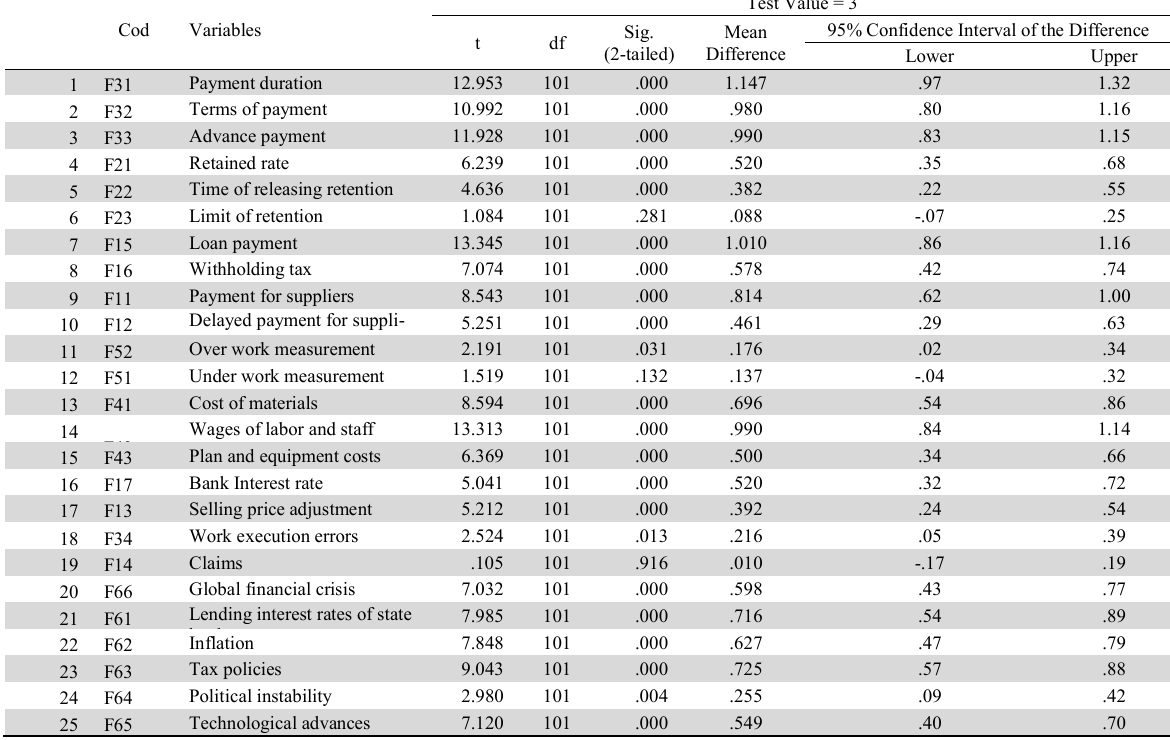
Table 5 KMO and Bartlett's Test Kaiser-Meyer-Olkin Measure of Sampling Adequacy. Bartlett's Test of